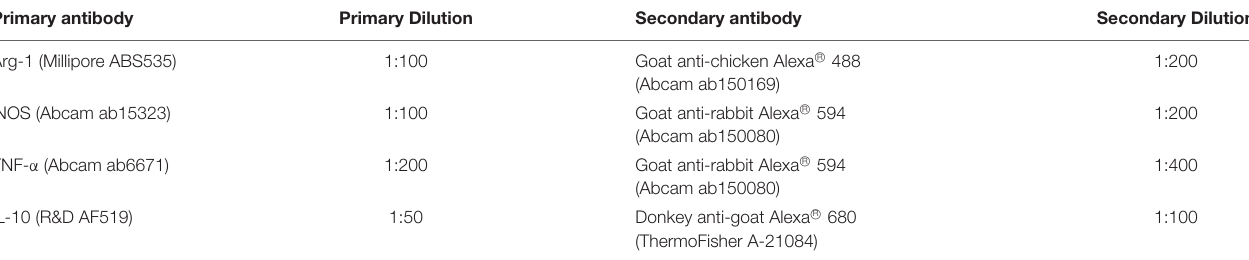
TABLE 1 | Primary and secondary antibodies and dilutions used for immunostaining in the in vitro studies. Primary antibody Primary Dilution Secondary